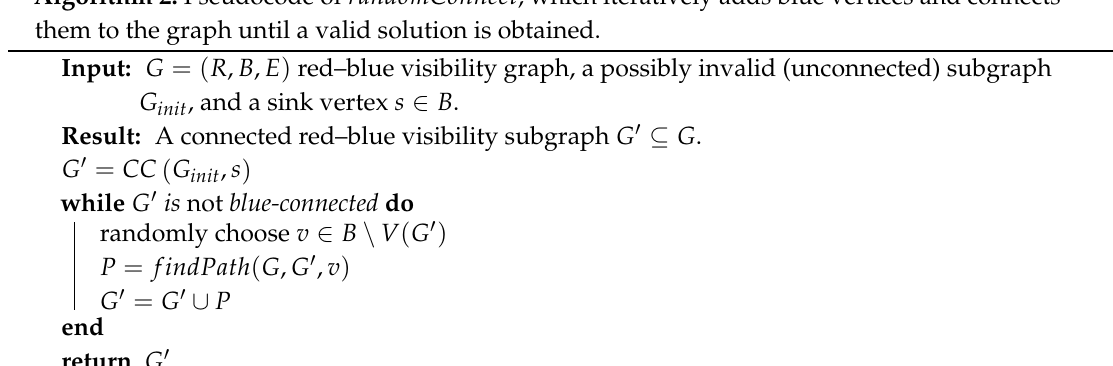
Algorithm 2: Pseudocode of randomConnect , which iteratively adds blue vertices and connects them to the graph until a valid solution is obtained.